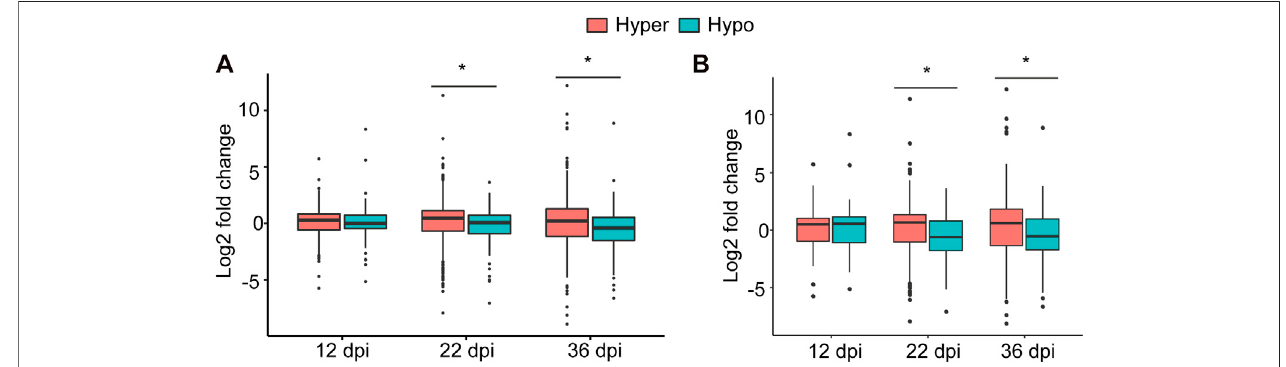
FIGURE 5 | Impact of DNA methylation of miRNAs on target gene expression. (A) : Boxplot comparing the expression levels (regardless of the statistical signi fi cance) of all target genes of hyper- and hypomethylated miRNAs identi fi ed at 12, 22, and 36 dpi. (B) : Boxplot comparing the expression levels of only statistically differentially expressed target genesofhyper and hypomethylatedmiRNAs identi fi edat 12,22,and 36dpi.Asterisksindicate statisticallysigni fi cantdifference ( p < 0.05) as determined by t test.